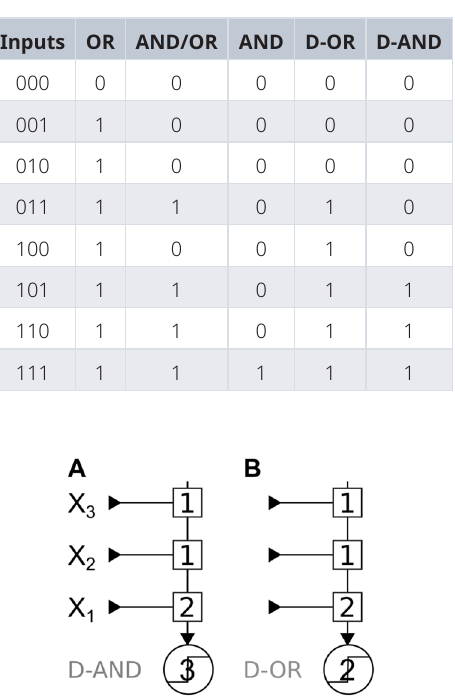
Figure 1. Minimal implementation of the Dominant AND computation (D-AND) and its dual by a linear threshold unit (LTU). Implementations of the D-AND where X is the dominant 1 input. Squares represent synapses with their synaptic weight, and circles stand for transfer functions. Here, the transfer functions are threshold functions with the given value as their threshold. A : Implementation of the D-AND, note that X has twice the synaptic 1 weight compared to the others. B : Implementation of the D-OR, note that we keep the same synaptic architecture and we only change the threshold of the transfer function.